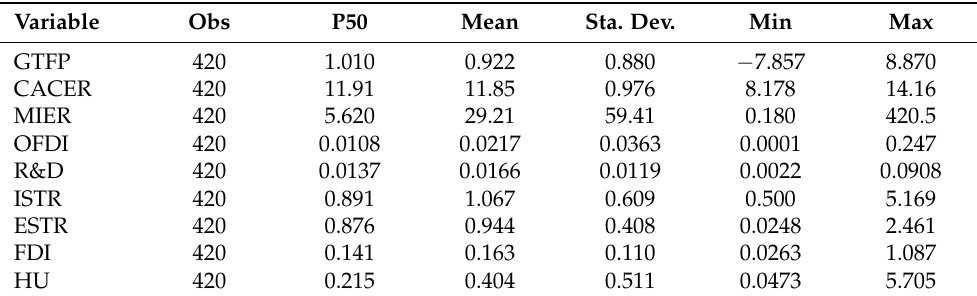
Table 4. Descriptive statistics of core variables.